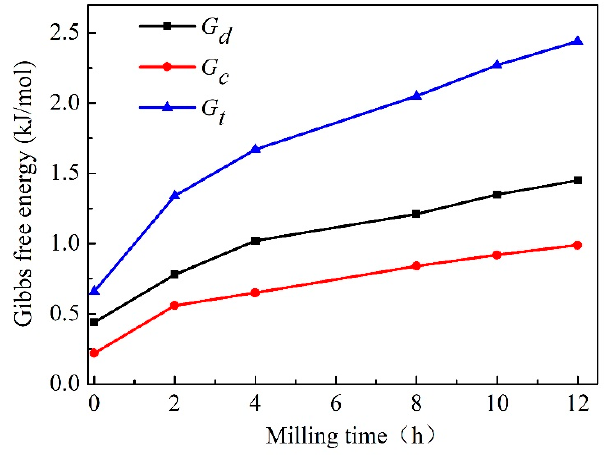
Figure 7. Effect of Cu crystallite size and dislocation density on Gibbs free energy. Figure 7. E ff ect of Cu crystallite size and dislocation density on Gibbs free